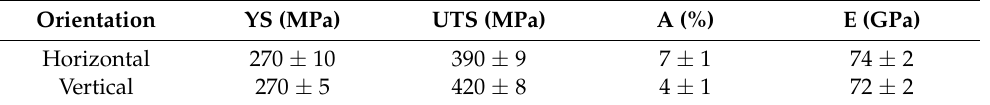
Table 4. Tensile properties for each building orientation. Mean values and standard deviations were obtained from all samples tested in each orientation without taking into consideration the production area.